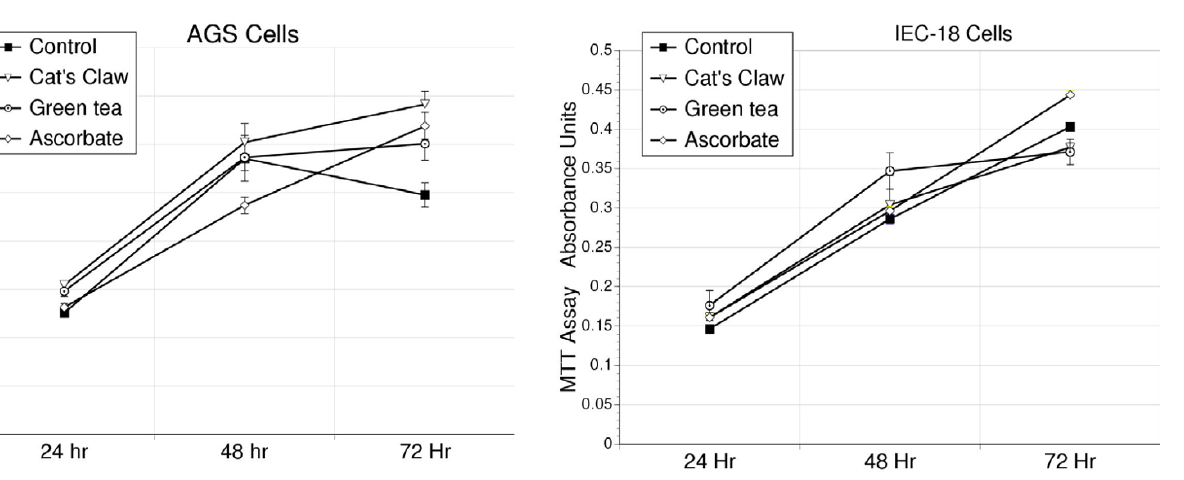
Figure 2 Proliferation curves for IEC-18 cells, based on the MTT assay, for cell respiration over a 72 hour period in response to the antioxidants – cat's claw, green tea, or vitamin C. These antioxidants had no detrimental effect on cell prolifer- ation at the concentrations used in this study, 10 µ